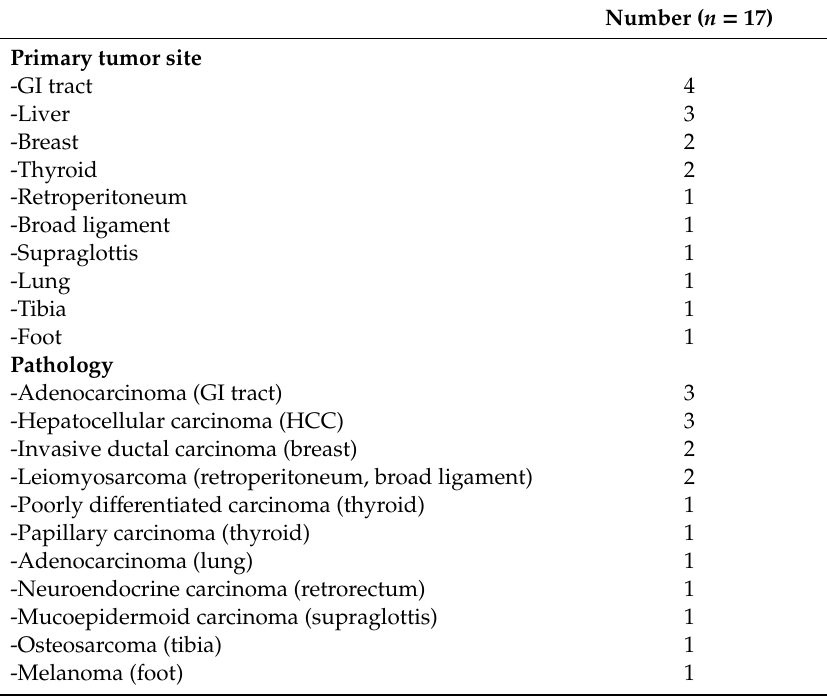
Table 2. Primary tumor origins and